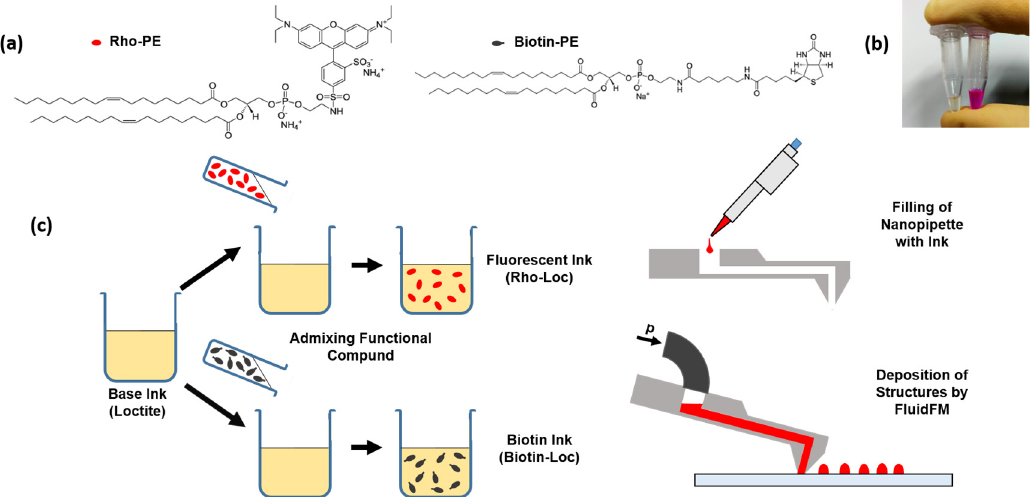
Figure 1. Ink preparation and printing. ( a ) Molecular structures of the phospholipids used for biofunctionalization. ( b ) Picture of the functionalized adhesive inks. ( c ) Scheme of functionalization and printing process.